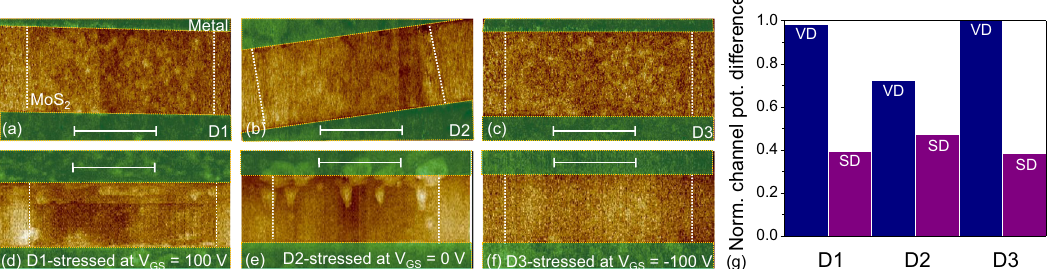
Fig. 7 Impact of LTES at different gate voltages on channel potential. a – c KPFM scans of three different VDs which are eventually stressed at V DS = 9 V different regimes of operation — d ON state, e near-threshold region and f OFF state. Regions shown in green are metal fi ngers that are placed on top of MoS 2 present within the white dotted lines. The difference in the average potential of metal and MoS 2 for these three devices is shown in ( g ). Irrespective of the stress conditions, SDs exhibit substantially lower channel potential. Scale bar: 1 µ m.